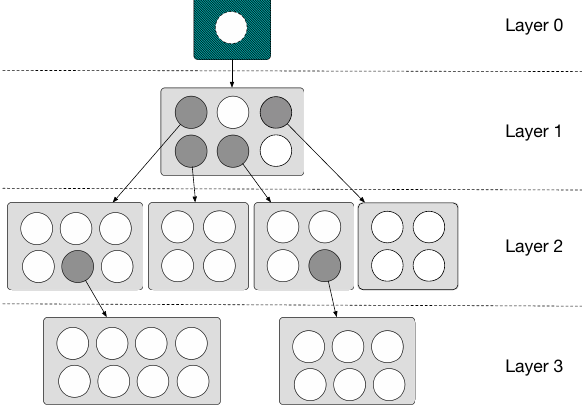
Figure 2. Growing Hierarchical Self-Organizing Map